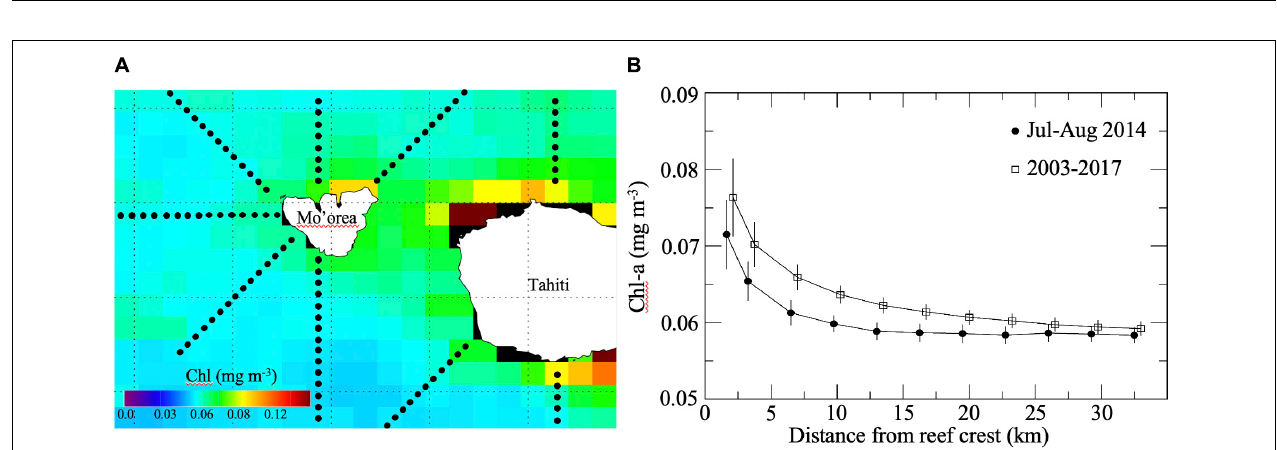
FIGURE 6 | Chlorophyll a distribution surrounding Mo’orea and near Tahiti from MODIS-Aqua data. (A) Map of the Chl distribution for the July–August 2014 time period and the 9 transects sampled. (B) Chl mean and standard error from all transects as a function of the distance to the reef crest for July–August 2014 (black circles) and over the 2003–2017 time period